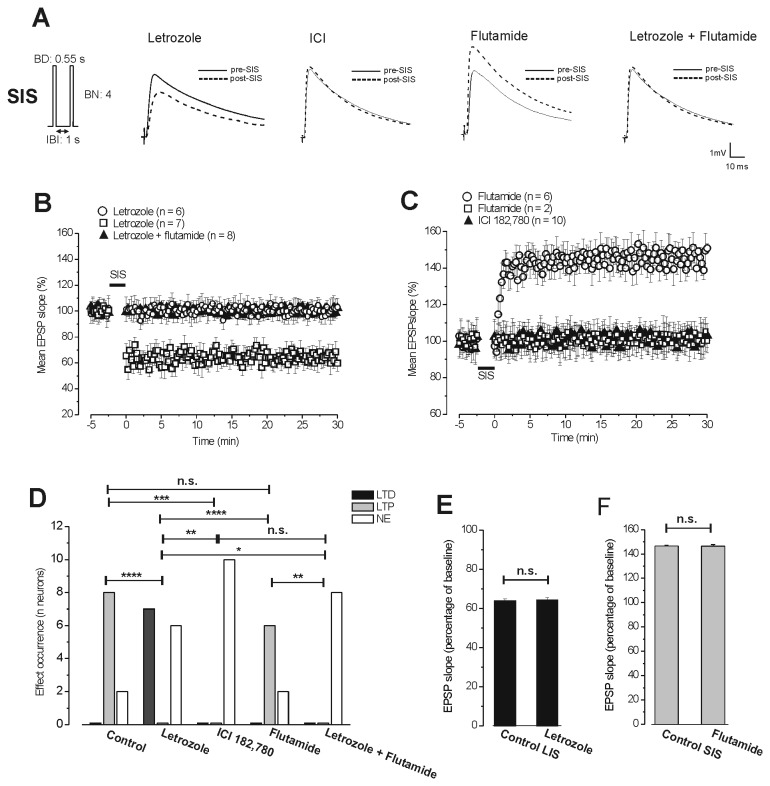
Involvement of estrogenic signal in the induction of LTP by the SIS protocol.
A. Averaged traces (n = 20) of EPSPs evoked before (thin traces: pre-SIS) and after SIS (dashed traces: post-SIS) in the presence of letrozole, ICI 182,780, flutamide and letrozole plus flutamide. (Left) Schematic drawing of stimulation pattern inducing LTP (SIS). B and C. Time courses of the responses induced by SIS under block of the E2 synthesising enzyme (B) and of ERs or ARs (C). B. Under letrozole SIS induces LTD (open square, n = 7) and no effect (open circle, n = 6), while under letrozole plus flutamide it has only no effect (filled triangles, n = 8). C. Under ICI 182,780 SIS has no effect (filled triangles, n = 10), while under flutamide it induces LTP (open circles, n = 6) or no effect (open square, n = 2). Note that induction of LTP is fully prevented under block of ERs (ICI 182,780) while in the majority of cases it is not affected by the block of ARs (flutamide). Moreover, under inhibition of the E2 synthesising enzyme (letrozole) LTP by SIS is prevented or reverted into LTD that is abolished by flutamide. D. Frequency occurrence (number of neurons) of LTD (black columns), LTP (grey columns) and no effect (NE, white columns) induced by SIS in the control condition and in the presence of letrozole, ICI 182,780, flutamide and letrzole plus flutamide (χ 2 test: *P<0.05, **P<0.01, ***P<0.005, **** P<0.001 and n.s. = no significant). E. Comparisons between the amplitude of LTD obtained by SIS under letrozole (n = 7) and LTD normally induced by LIS in control condition (n = 8) and F. Comparison between the amplitudes of LTP induced by SIS in control condition (n = 8) and in the presence of flutamide (n = 6) (one-way ANOVA: n.s. = no significant).